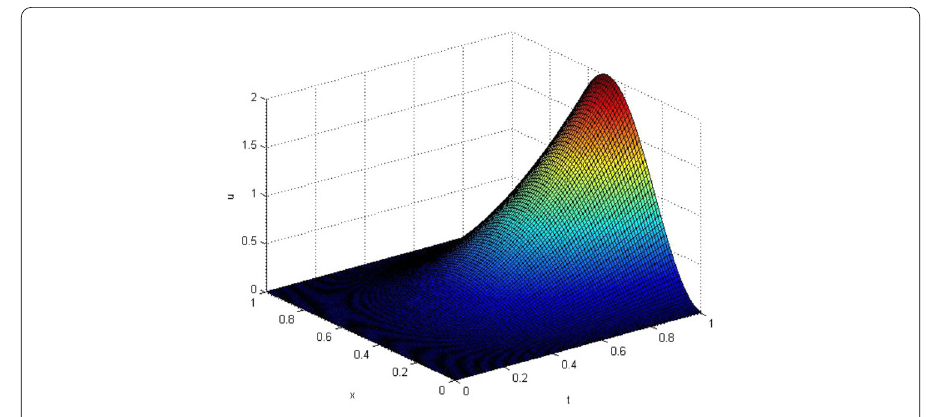
Figure 1 The exact solution to problem